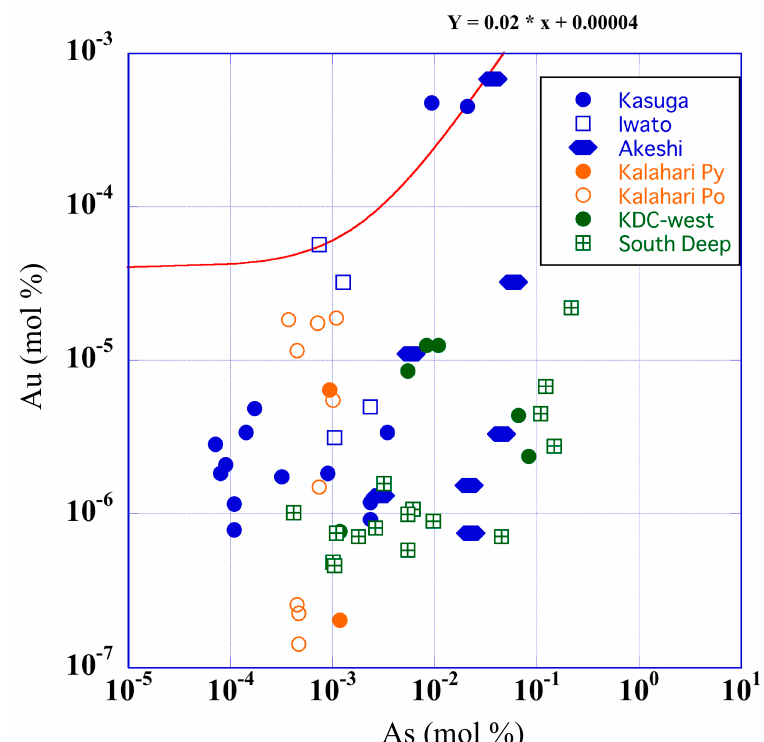
Figure 8. Log–log plot of the relationship between the Au and As concentrations (mol%), including all the SIMS data for the pyrite and pyrrhotite. Every deposit is allocated a symbol in the legend. The solid line represents the empirical solubility limit of Au in pyrite as a function of As concentration [18]. Note that almost all the data lie on or below the line. See Section 5.4 for details. The labels ‘Kalahari Py’ and ‘Kalahari Po’ represent pyrite and pyrrhotite grains, respectively, from the Kalahari deposit.